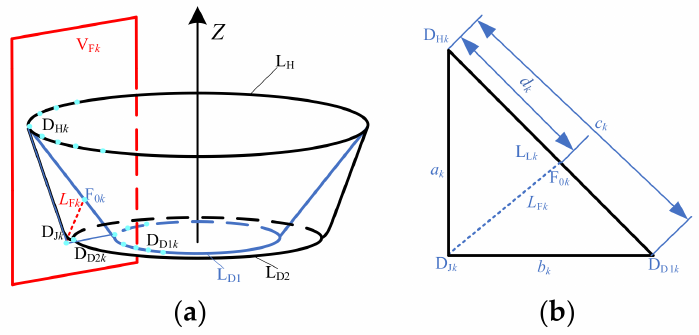
Figure 4. Determination of auxiliary lines: ( a ) stereogram and ( b ) longitudinal section.